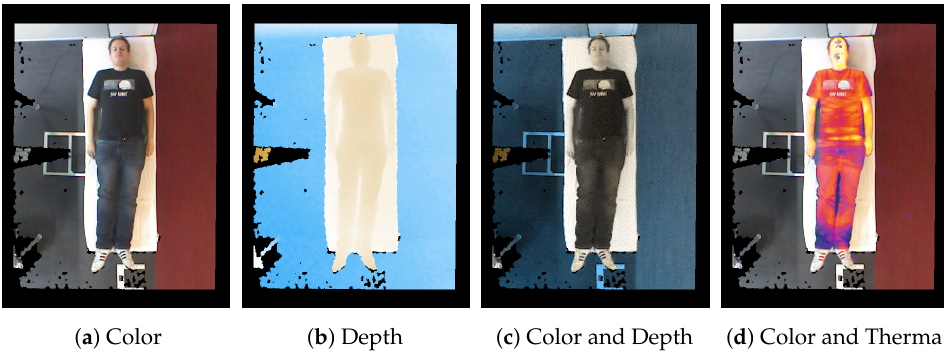
Figure 3. Visualization of sensor fusion: Figure ( a ) shows the raw color stream from an RGB-D camera. The depth stream can be visualized using a colormap, here drawing blue values for far objects and drawing white and orange for nearer objects ( b ). The stream from the thermal camera can be visualized in several ways: either it is drawn with false-color representation ( c ) or can be combined with other streams—here a combination of the color stream, highlighted with temperature ( d ). The here presented image-based sensor fusion is achieved by intrinsic and extrinsic camera calibration, which is presented in Figure